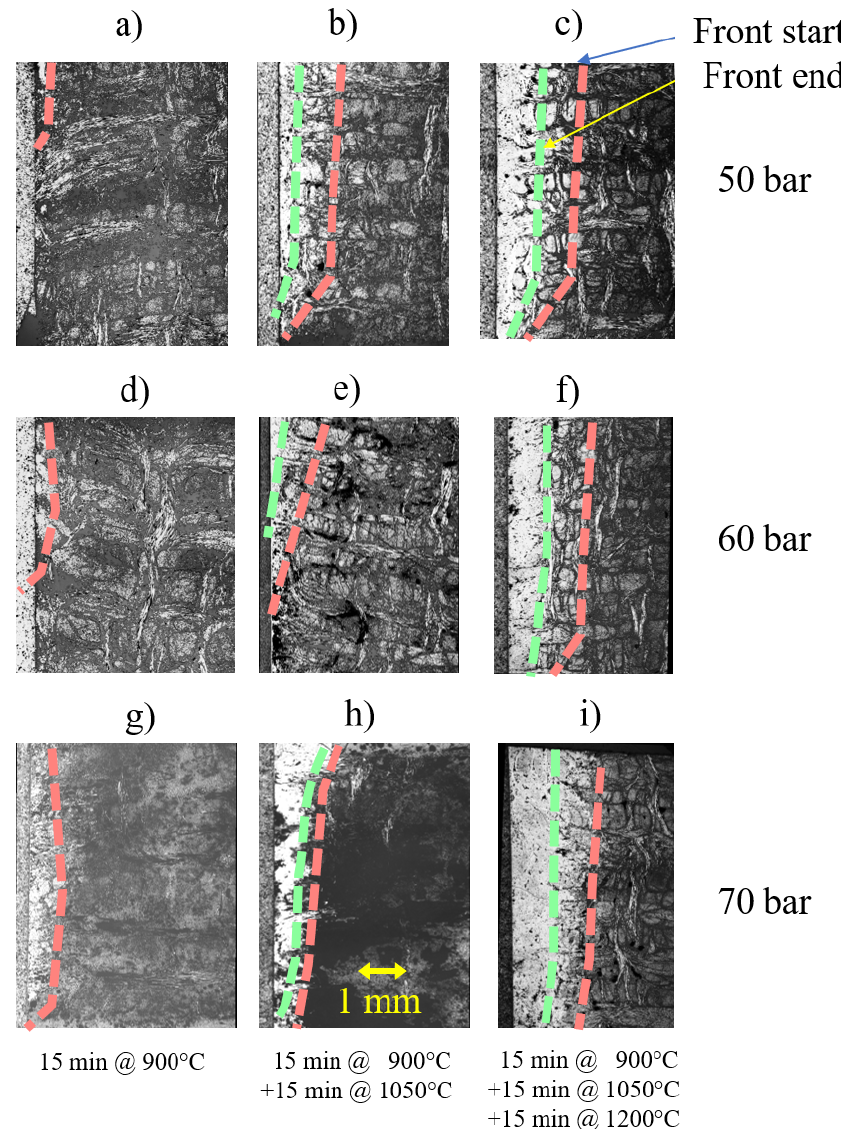
Figure 10. ( a – i ) Transverse micrographs of samples obtained after runs #P2 to P10, respectively. The scale bar is common to all micrographs. The approximate locations of the front starts and ends are indicated by red and green dashed lines,